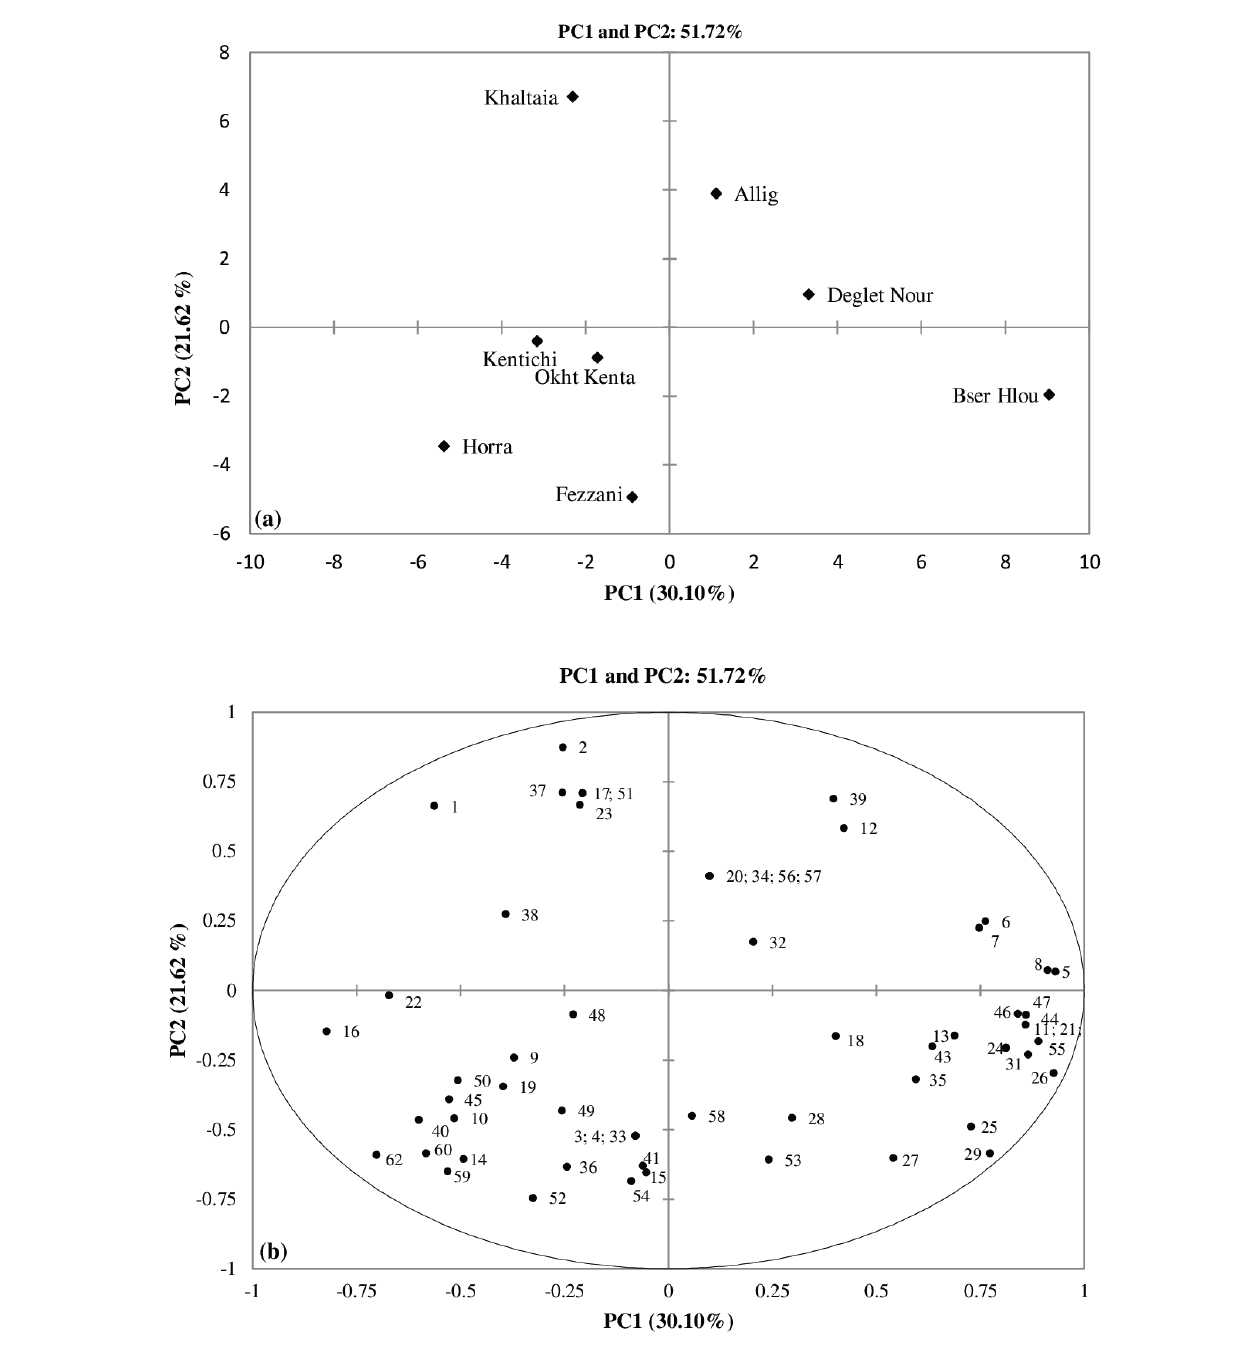
FIGURE 1 - (a) Principal component analysis (PCA) case scores date palm fruits based on first and second principal components. (b) : PCA variable loadings of date palm fruits volatile compounds based on first and second principal components. (see Table V for list of